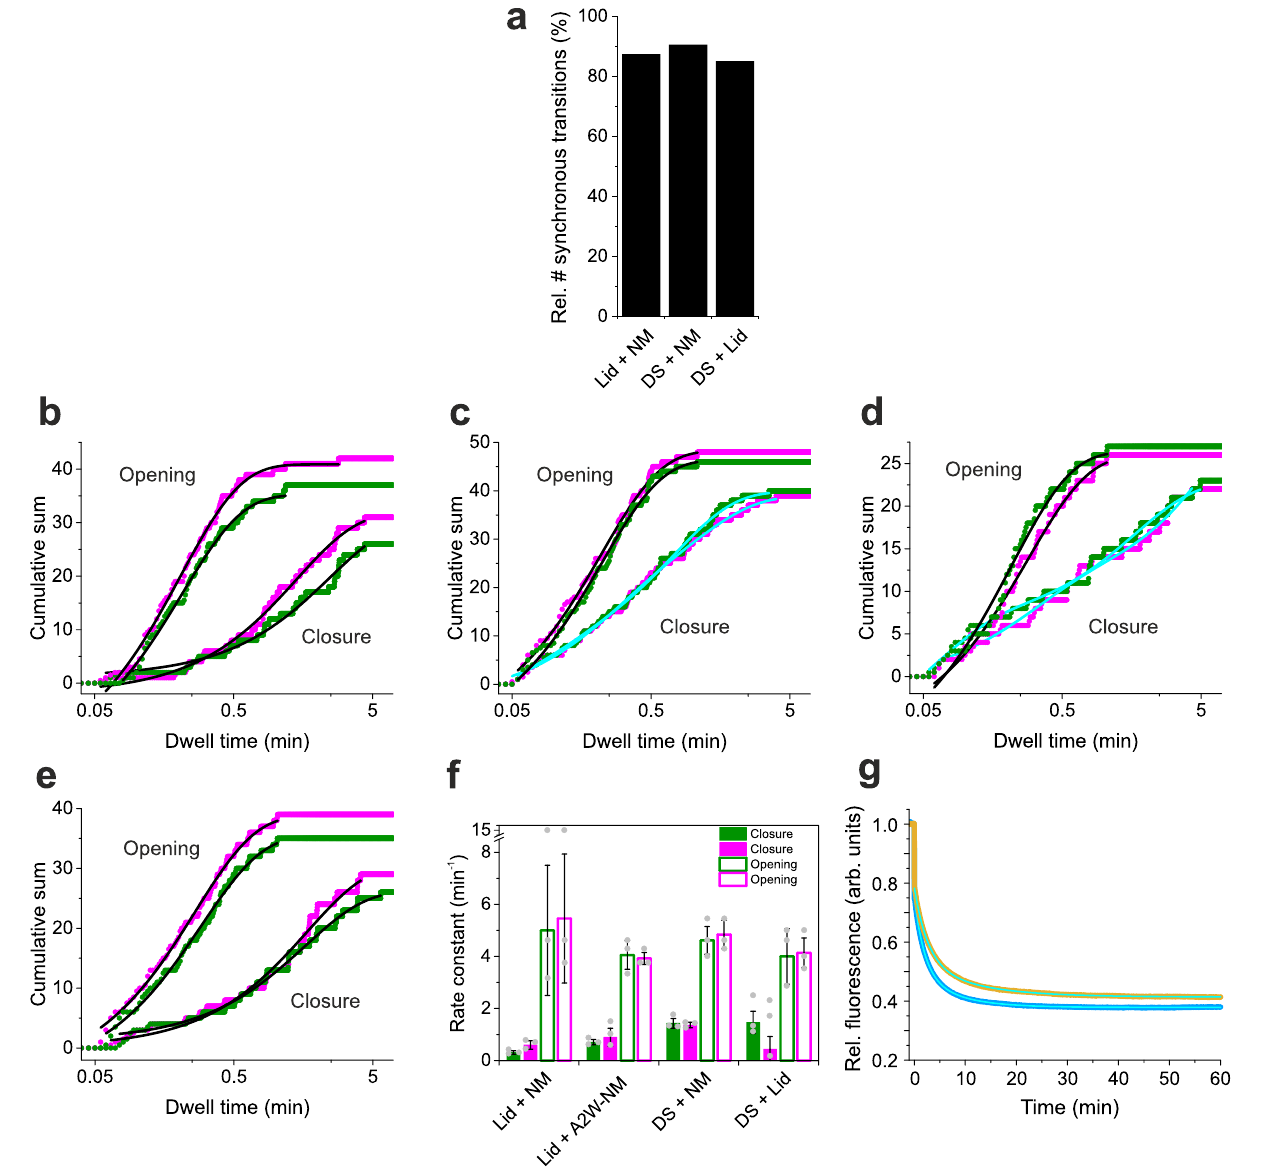
Fig. 5 Cooperativity and kinetics of conformational cycling of Hsp90. a Relative number of synchronous transitions detected from two-colour smPET fl uorescence intensity time traces recorded from pairwise reporters for Lid, DS and NM-association. b – e Cumulative sum plots of dwell times in fl uorescent states (kinetics of closure) and in fl uorescence-quenched states (kinetics of opening) determined from the reporter pairs Lid Atto542 -NM JF646 ( b ), DS Atto542 -NM JF646 ( c ), DS Atto542 -Lid JF646 ( d ) and Lid Atto542 -A2W-NM JF646 ( e ). Data shown in green and magenta are from fl uorescence of Atto542 and JF646, respectively. Black lines are mono-exponential fi ts to the data. Cyan lines are bi-exponential fi ts to the data. f Mean rate constants of closure (closed bars) and opening (open bars) determined from fi ts to the data shown in b – e . Values are the mean of three measurements and errors are standard deviations ( n = 3; ±s.d.). g Bulk fl uorescence measurements of kinetics of NM-association of Hsp90 probed by a one-colour PET reporter involving JF646 as a probe (orange). Data from the same construct but containing mutation A2W on the opposite subunit are shown in blue. Measurements were carried out on a benchtop fl uorimeter. 4 mM AMP-PNP was added at t = 0 min. Cyan lines are bi-exponential fi ts to the data. Source data are provided as a Source Data fi